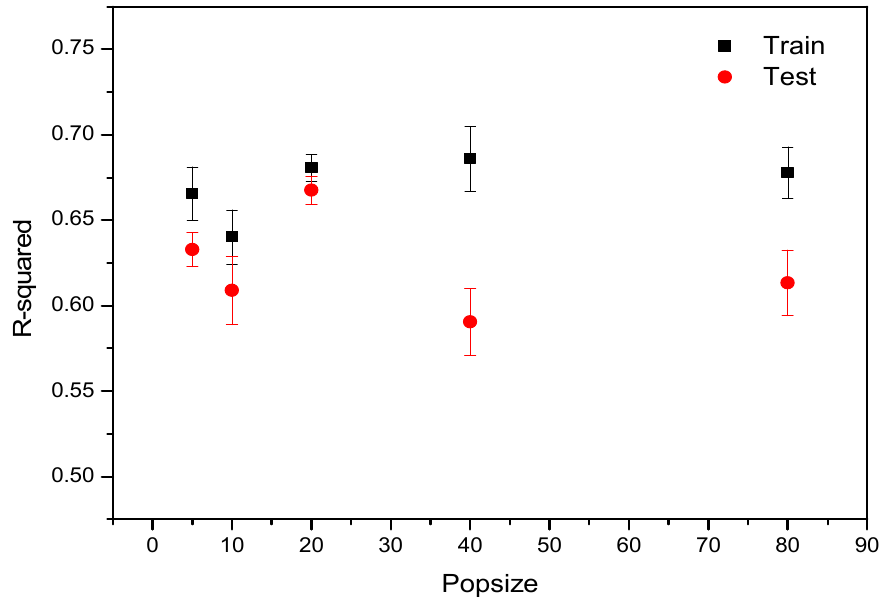
Figure 6. Effect of population size on the variations in R 2 between the measurements and simulation.